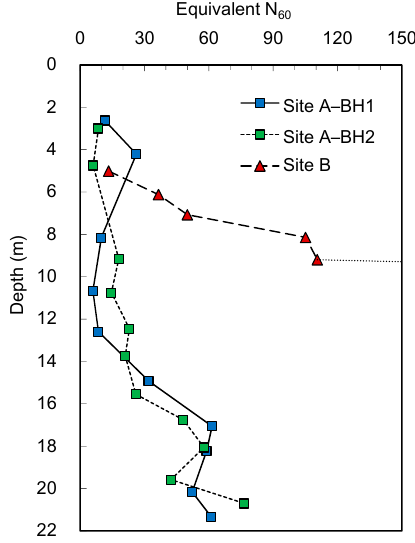
Figure 9. Profiles of the equivalent N 60 obtained from ICP.